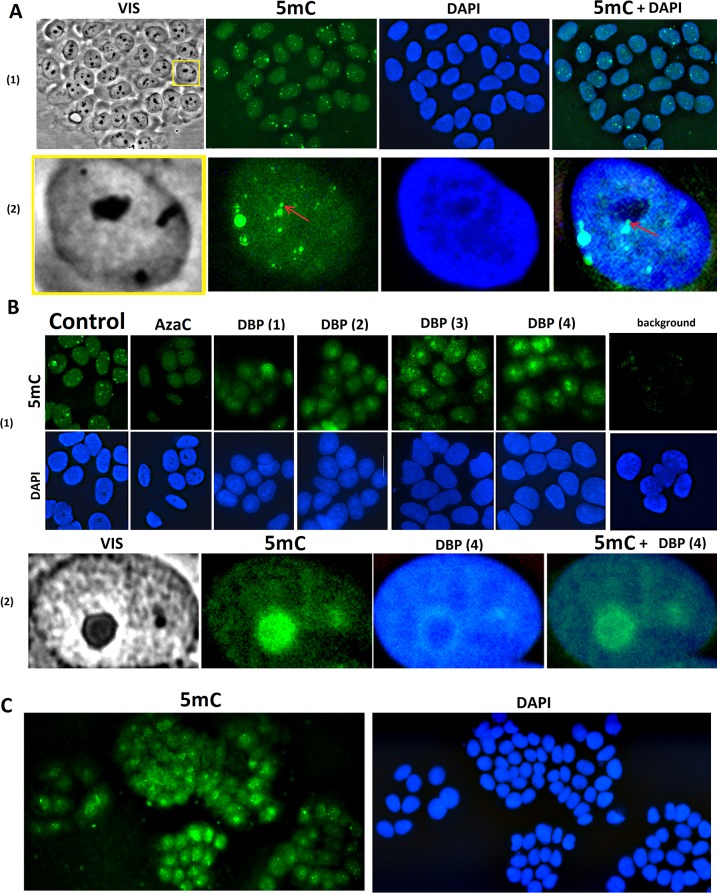
DNA methylation in nuclei of the control MCF-7 cells.A. Cells were processed for immunofluorescence staining with anti 5-mC antibody. (1)—Magnification X60; (2)—For analysis of the nuclei the photo was enlarged by an order using computer processing. The arrow points to the methylated DNA block close to the nucleolus. B. (1)—DNA methylation in nuclei of the control MCF-7 cells and the cells treated with 10 μM AzaC or 20μM DBP(1–4), 72 h. Background: Control cells were only treated with secondary antibodies conjugated with FITC. (2) The photo was enlarged considerably for the analysis of nuclei size. The nucleus of the cell cultivated with DBP(4) is shown for an example. C. An example of the different DNA methylation level in cells’ nuclei that were cultivated in the presence of 20μM DBP(4), 72 h. A,B(1) and C—Cell nuclei were additionally colored with DAPI.